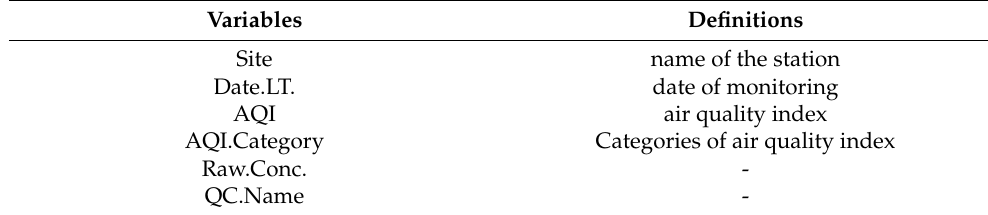
Table 5. Variables and definitions for the Vientiane area.